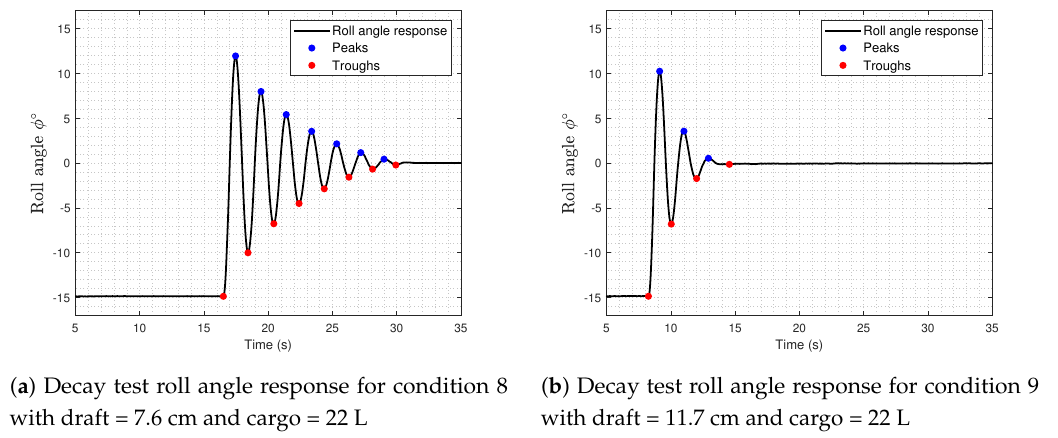
Figure 13. Effect of vessel draft on the dynamic response of the FPSO model during roll decay test.